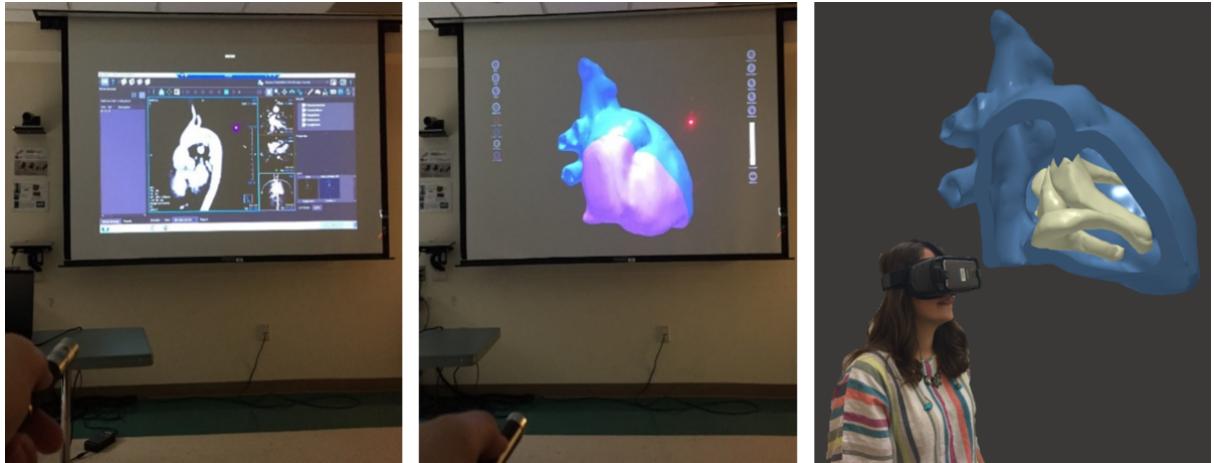
Figure 2. The setup of the conventional (left), nonimmersive virtual reality (middle), and full-immersive virtual reality (right) display systems in the